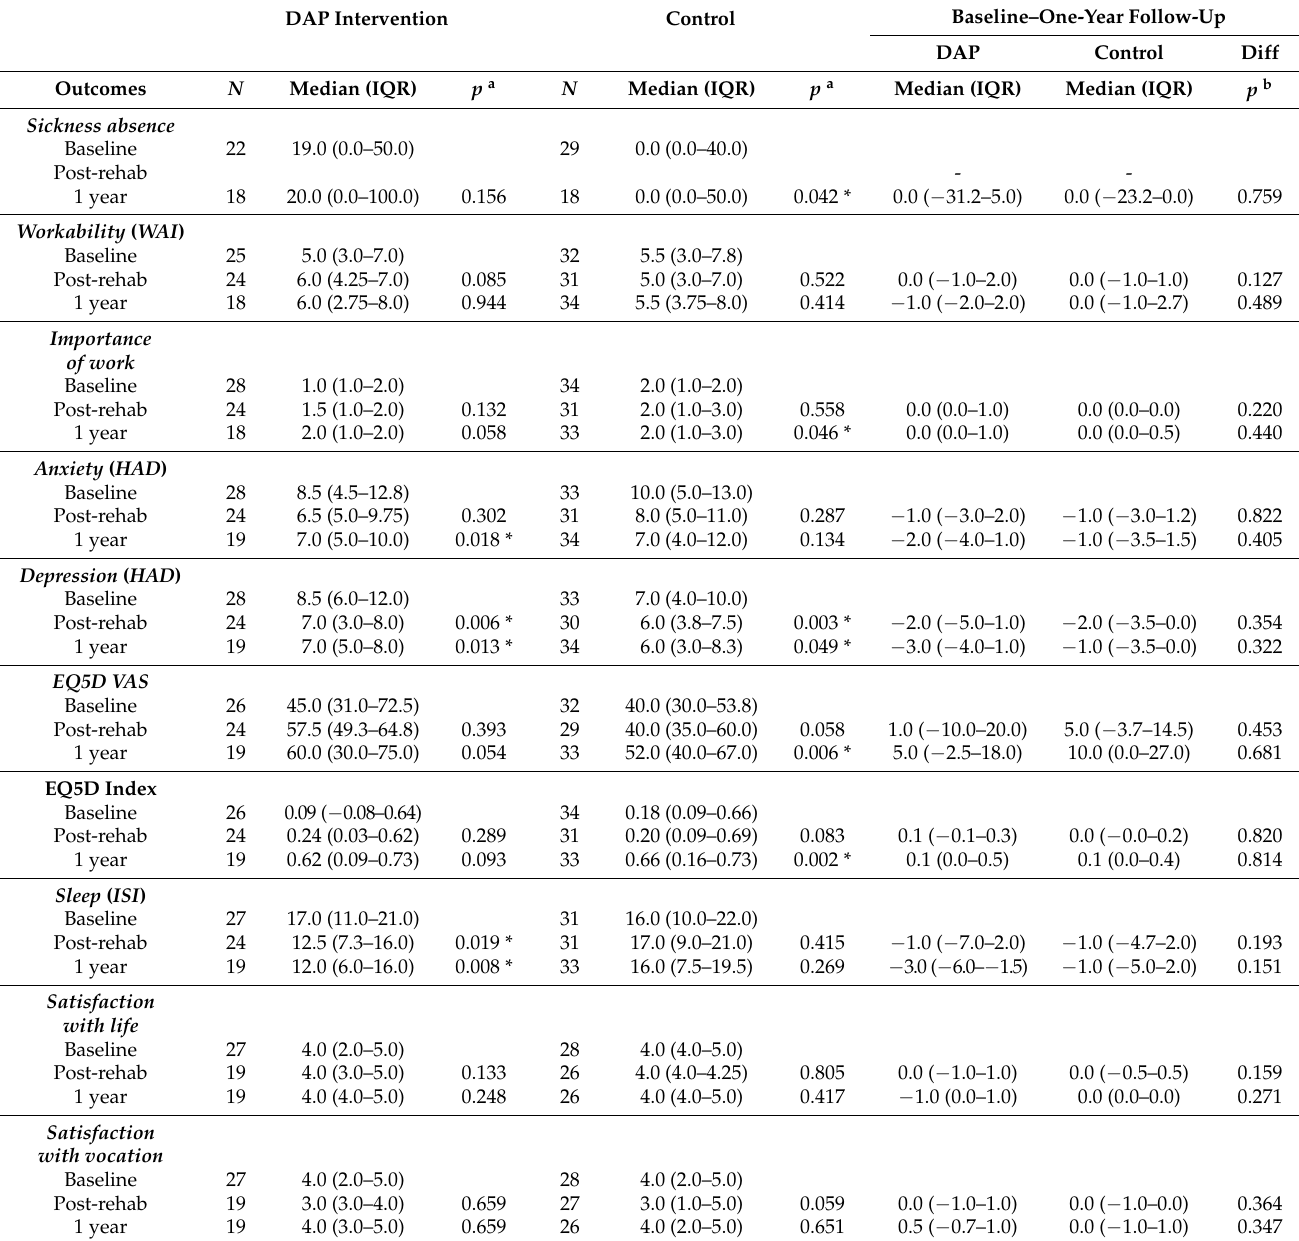
Table 4. Results from the analyses of changes in outcomes after DAP post rehabilitation and at 1-year follow-up in the intervention group and control group, respectively. The right column presents differences between the intervention group and the control group in changes (baseline–post rehab, and baseline-1 year follow-up). Differences between baseline and post rehab or baseline and 12-month follow-up in the DAP-intervention group and control group respectively, were analysed by Wilcoxon signed rank